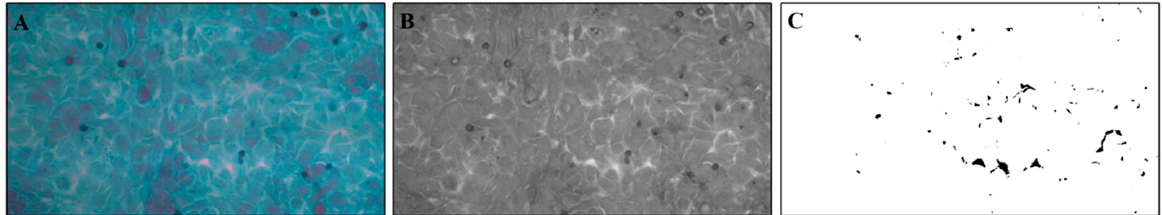
Figure 1. ImageJ threshold tool for intercellular spaces analysis on Papanicolaou staining. The original images (panel A ) were first converted to black and white 8-bit images (panel B ), and subsequently, the threshold tool was used (panel C ).